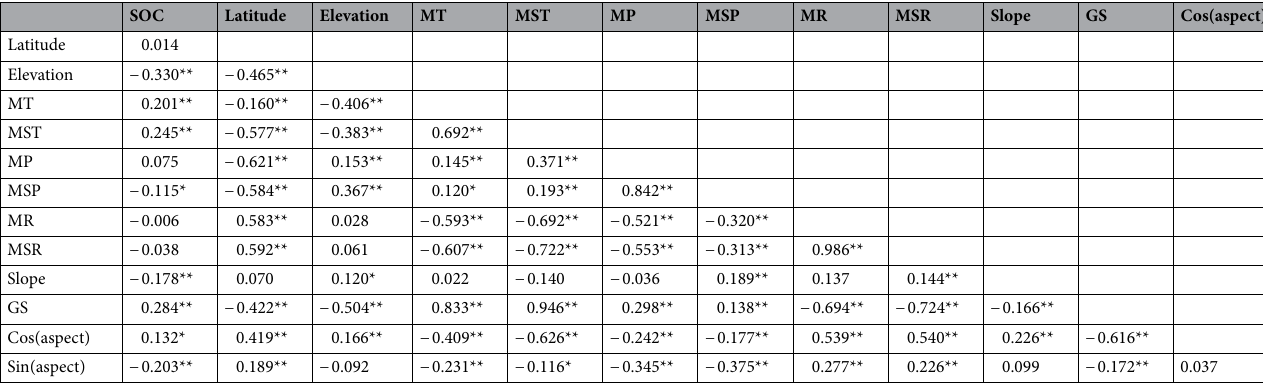
Table 2. Correlation matrix of SOC stocks with climatic and topographic variables. SOC soil organic carbon stock (kg m −2 ), MT mean temperature (°C), MST mean summer temperature (°C), MP mean